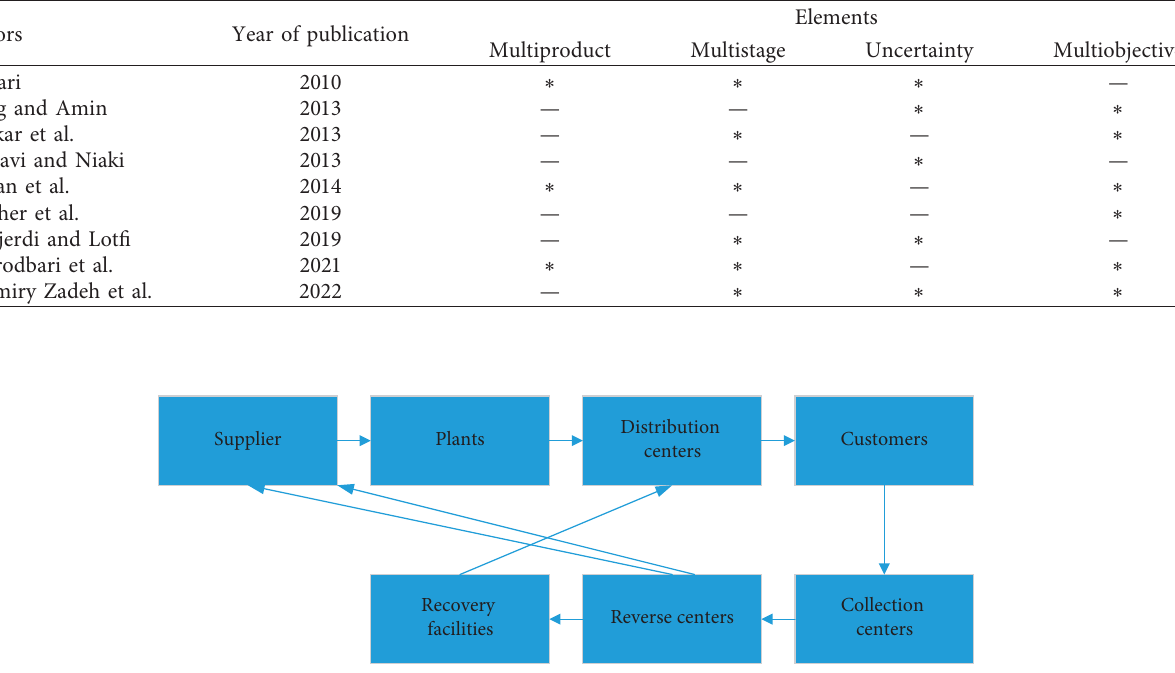
Figure 1: Levels of the corresponding supply chain in the present study.